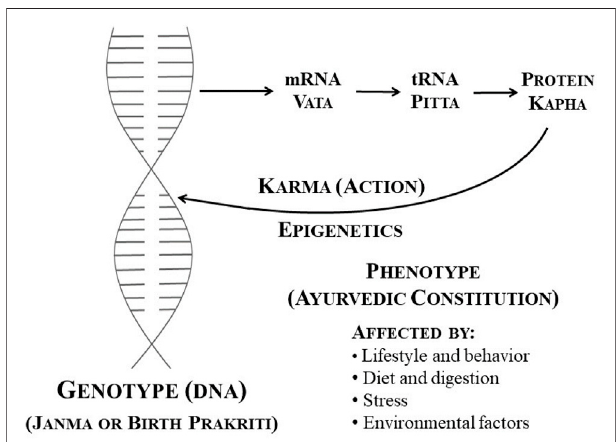
FIGURE 1 | DNA and cellular activity, as well as their relationship to Ayurveda [Adopted from (Sharma and Keith Wallace, 2020) under CC BY 4.0